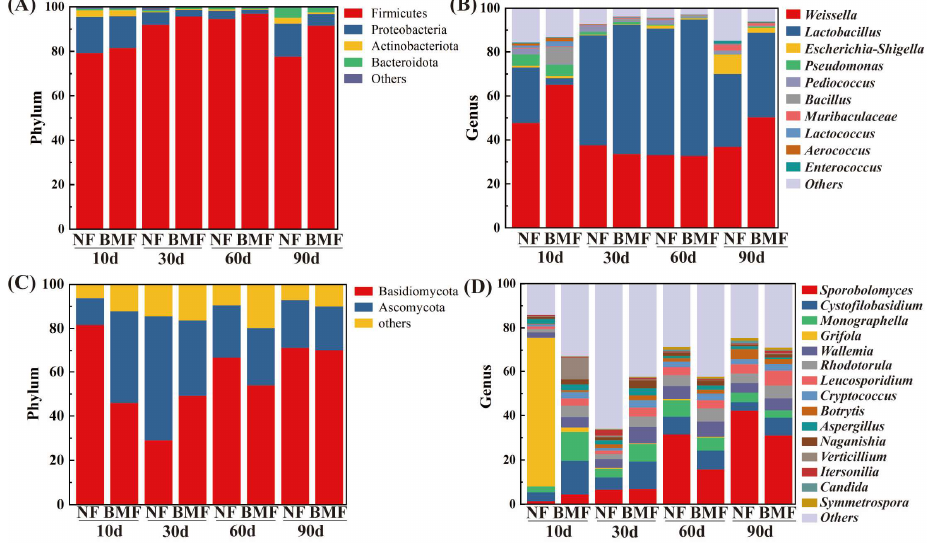
Figure 4. The comparison of relative abundance of microbes on days 10, 30, 60, and 90 of fermenta- tion in NF and BMF. ( A ) Relative abundance (%) of bacteria at the phylum level. ( B ) Relative abundance (%) of bacteria at the genus level. ( C ) Relative abundance (%) of fungi at the phylum level. ( D ) Relative abundance (%) of fungi at the genus level.